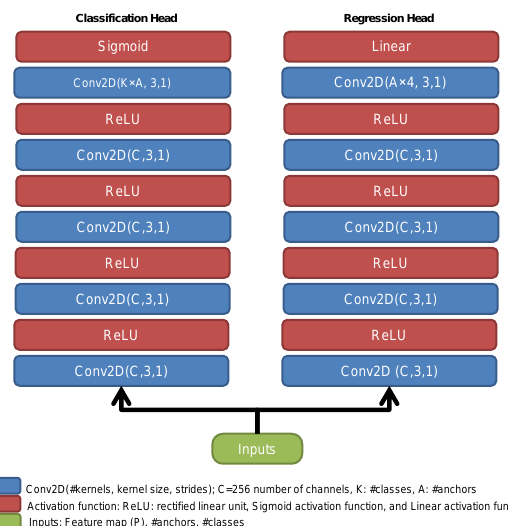
Figure 4. The architecture of classification and regression